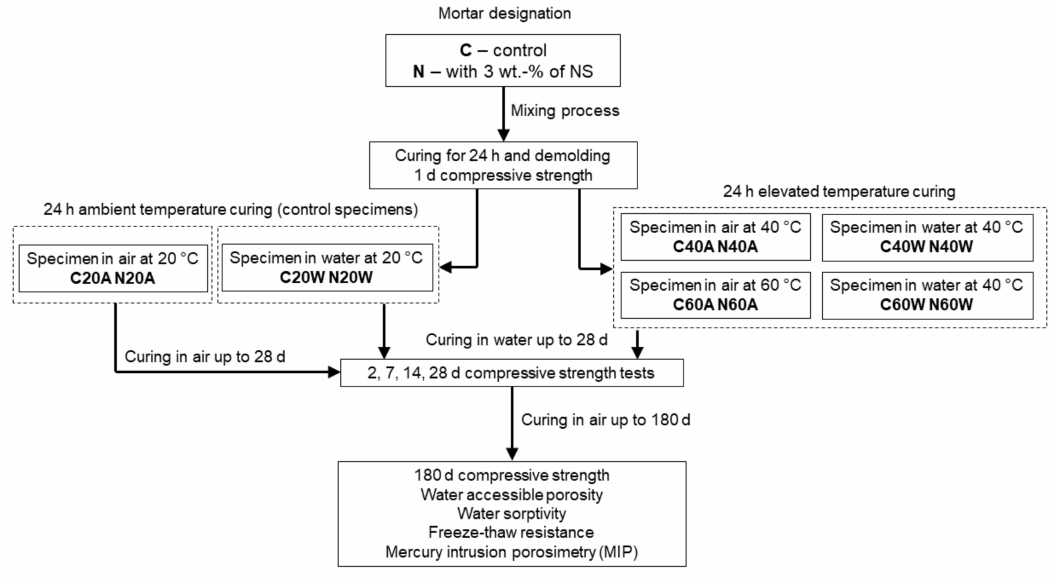
Figure 3. Experimental curing method